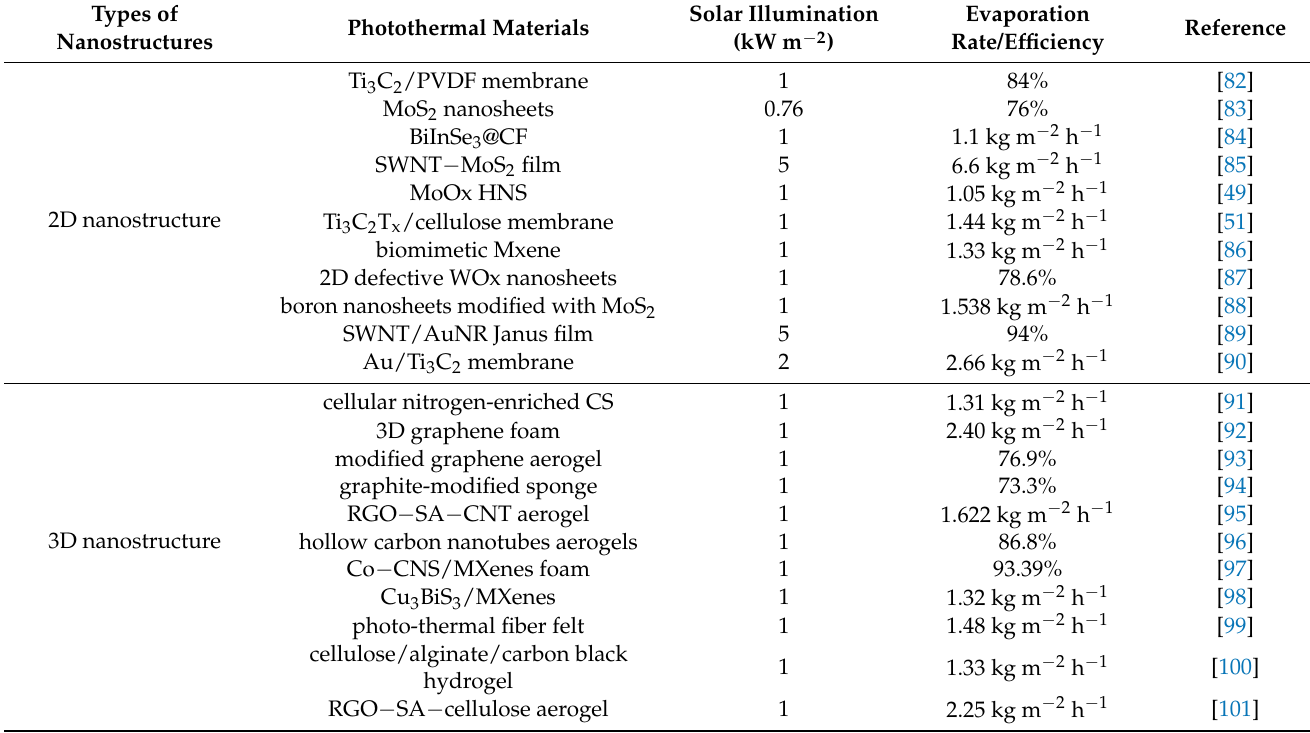
Table 1. Summary of the research on the 2D and 3D nanostructured materials for photothermal seawater evaporation. Types of